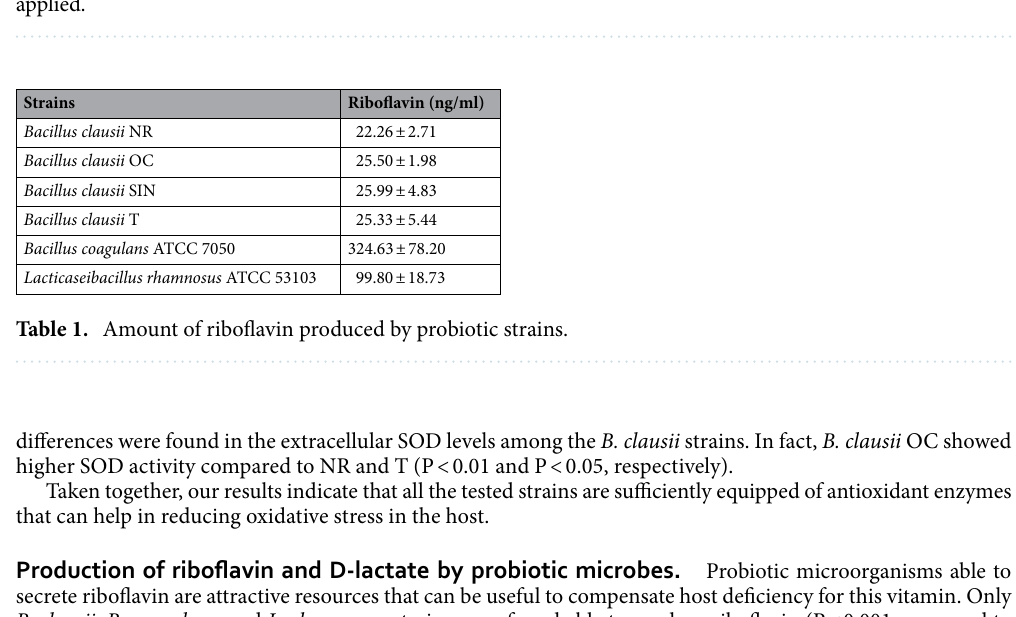
Figure 4. Quantification of catalase (CAT) and superoxide dismutase (SOD) activities produced by probiotic strains. ( a ) CAT activity (nmol/min/mg) determined in cell lysates (light grey bars). ( b ) CAT activity (nmol/ min/mg) determined in culture supernatants (dark grey bars). ( c ) SOD activity (% of inhibition/mg) determined in cell lysates (light grey bars). ( d ) SOD activity (% of inhibition/mg) determined in culture supernatants (dark grey bars). Three independent biological replicates with two technical replicates each were performed. Data are expressed as the mean ± standard deviation. The ANOVA for independent data followed by Tukey HSD test was applied.